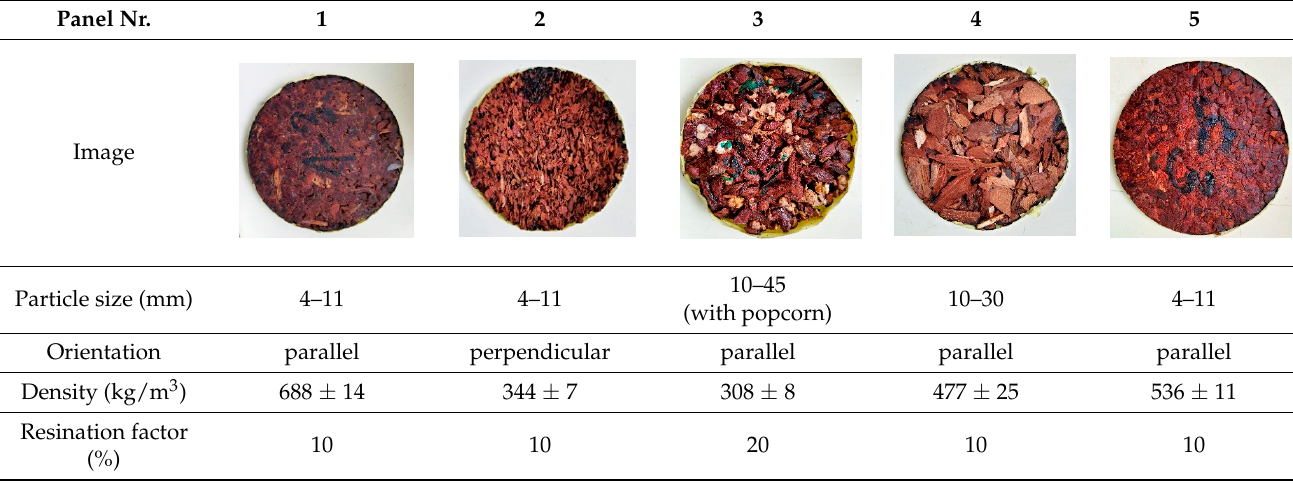
Table 1. Overview of parameters of tested specimens made of bark-based boards. Panel Nr.